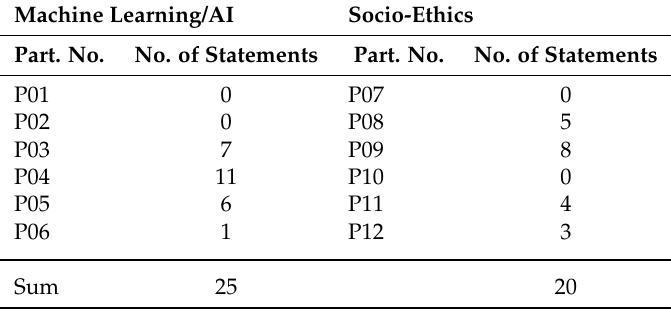
Table 5. Number of statements per interviewee related to behaving